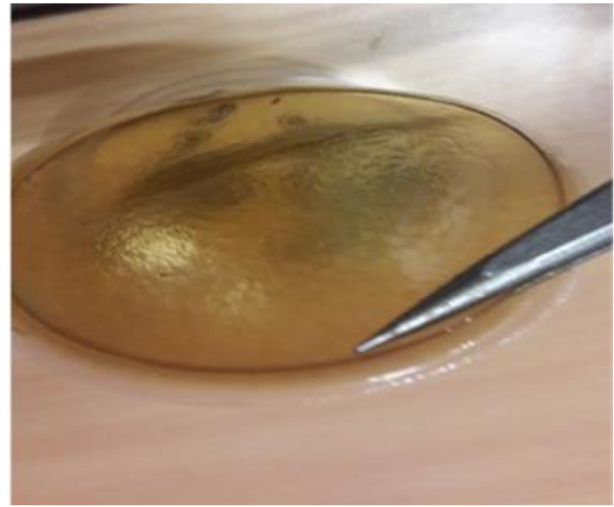
Figure 1. Silk fibroin film obtained from solvent systems with good solvation power.